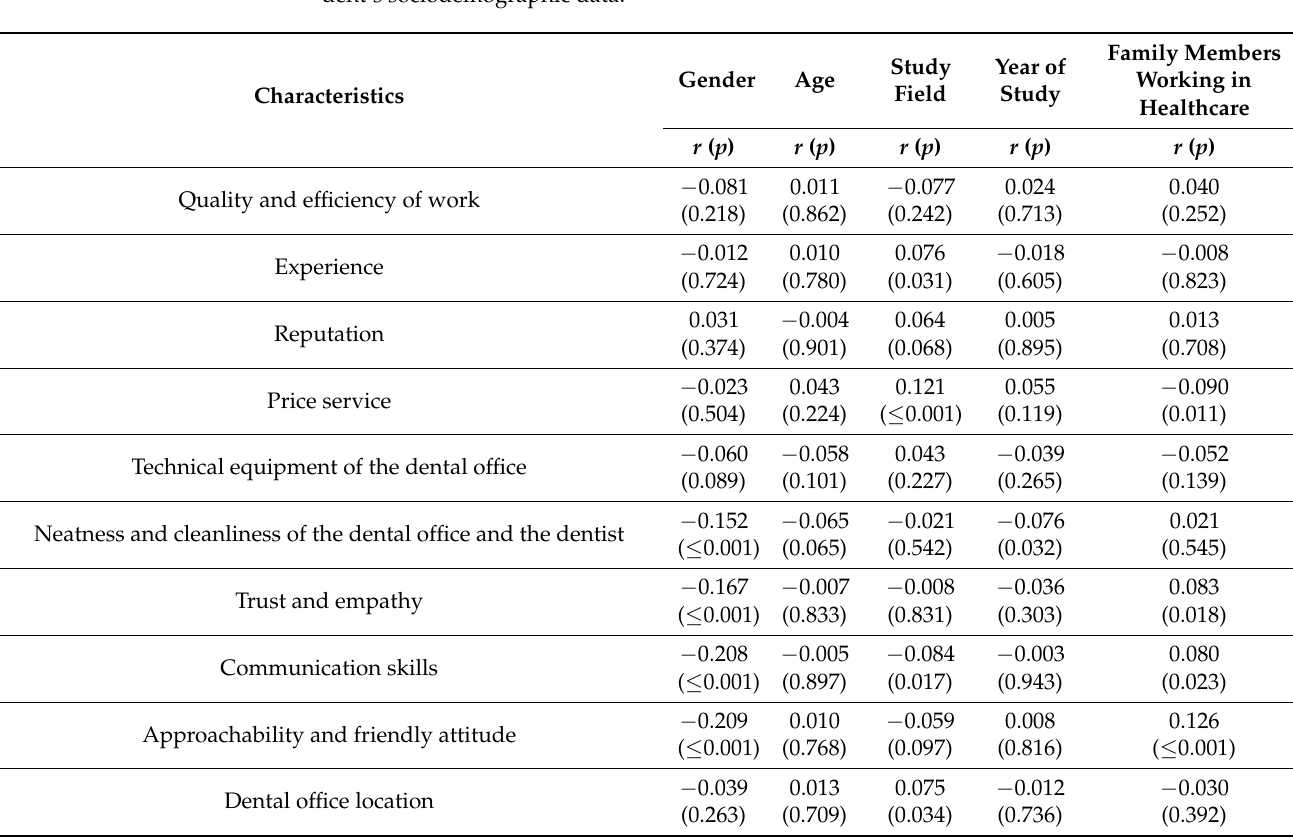
Table 6. Correlation between in the most important reason for choosing the dentist and the respon- dent’s sociodemographic